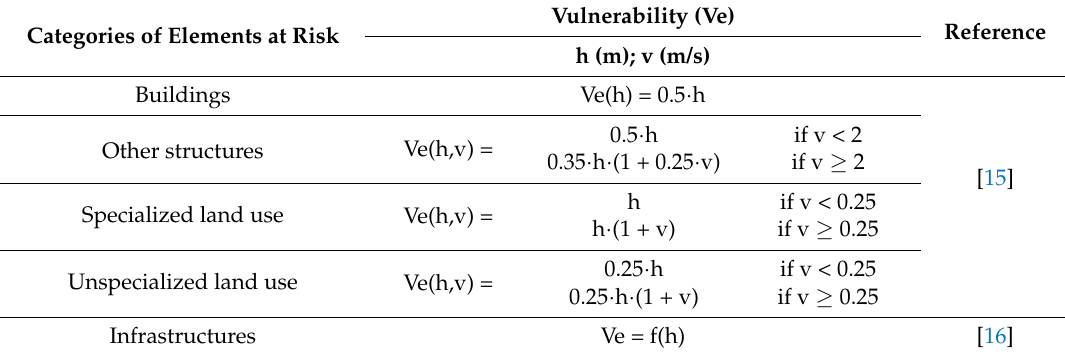
Table 3. Flood damage